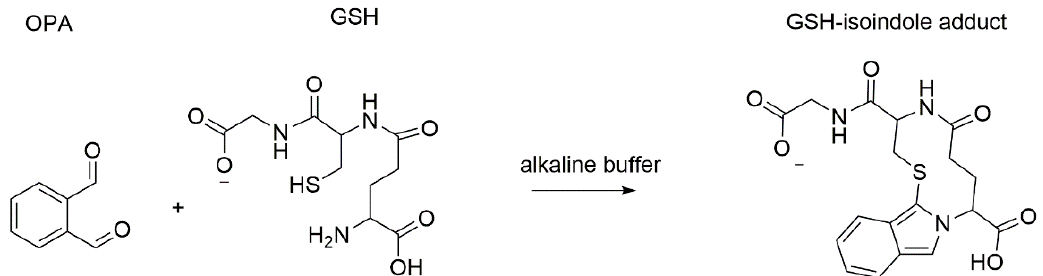
Figure 1. Glutathione (GSH) reaction with ortho -phthalaldehyde (OPA) (left) produces the stable isoindole detectable fluorophore (right).